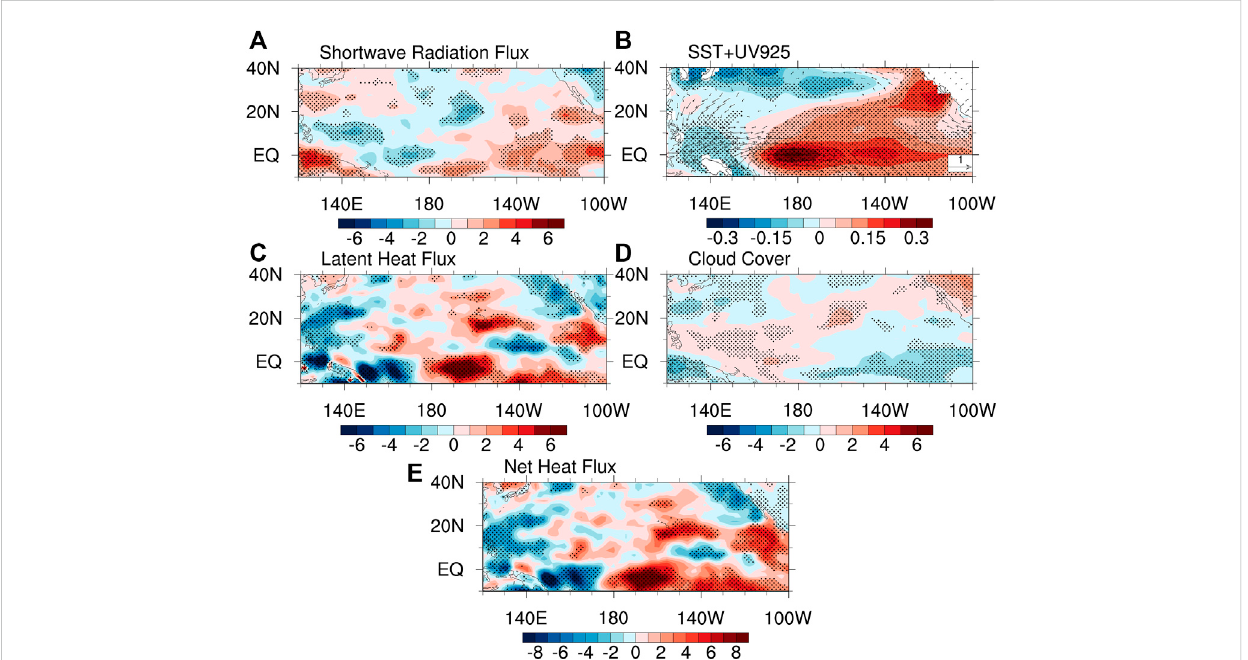
FIGURE 4 Regression of (A) shortwave radiation fl ux anomalies (units: W m − 2 ), (B) SST anomalies (shaded; units: ° C) and wind anomalies at 925 hPa (vector; units: m s − 1 ; vectors denote statistical signi fi cance at the 95% con fi dence level), (C) latent heat fl ux anomalies (units: W m − 2 ), (D) cloud cover anomalies (units: %), and (E) net heat fl ux anomalies (units: W m − 2 ) in the lagging 2 years onto the SSN index on the decadal time scale. Dots indicate statistical signi fi cance at the 95% con fi dence